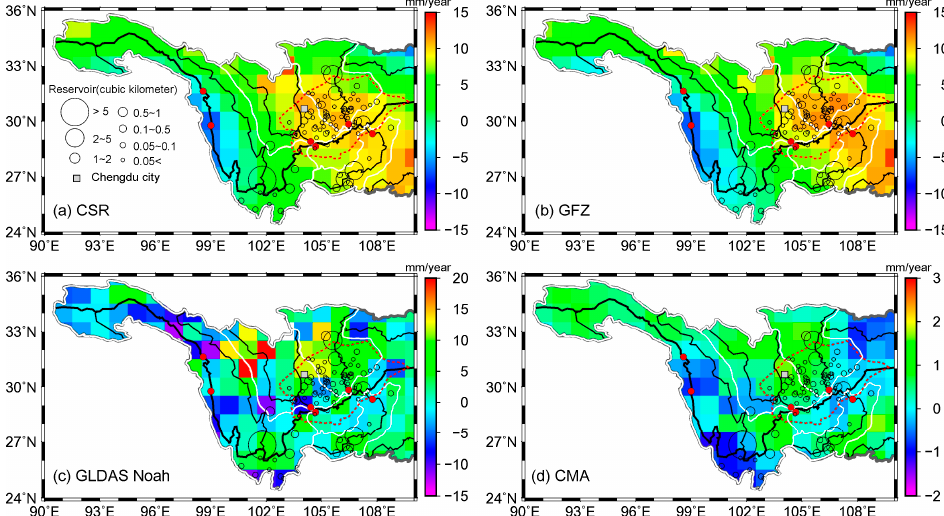
Figure 2. Linear trend variability of changes in: ( a ) CSR TWS; ( b ) GFZ TWS; ( c ) GLDAS Noah SM; and ( d ) CMA precipitation for the period of January 2003 to February 2015. Note that precipitation data have been resampled in a 1° × 1° grid for a reliable comparison.